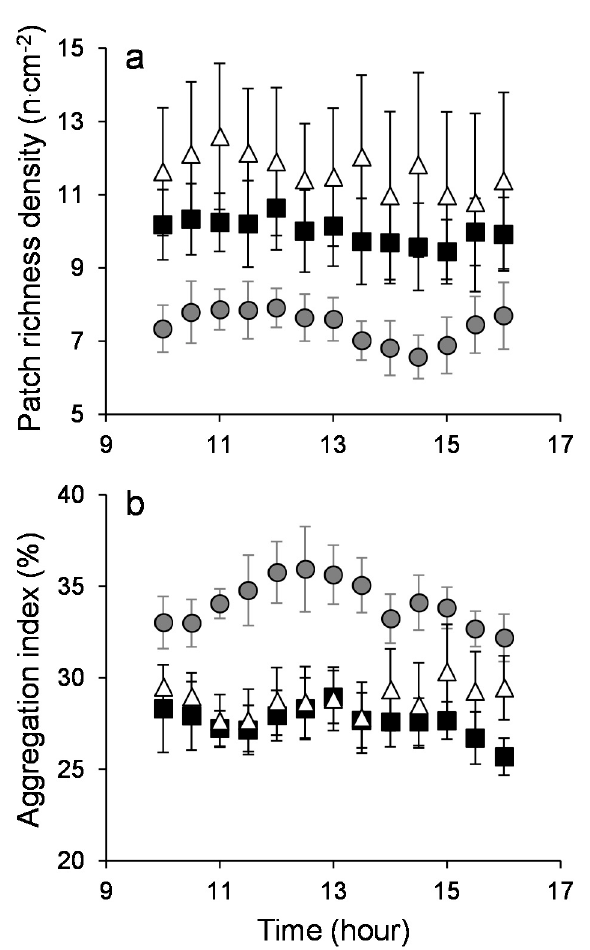
Figure A6. Dynamics of the patch richness density, PRD ( a ), and the aggregation index, AI ( b ), of the leaf surface temperature distributions (mean+se) in the three treatments: intact leaves (grey circles), leaves covered with vegetable oil (white triangles) and leaves infested with green apple aphids (black squares). The PRD is the count of different temperature values (with a 0.1 °C resolution) relative to the total number of pixels in the thermographic image: it is close to zero when the diversity of temperature values is small, and it increases when every single pixel has a unique temperature value. The AI defines the way groups of pixels with similar temperatures are arranged spatially: it is zero when similar pixels are spread across the surface, and it equals 100 when the aggregation is maximal.